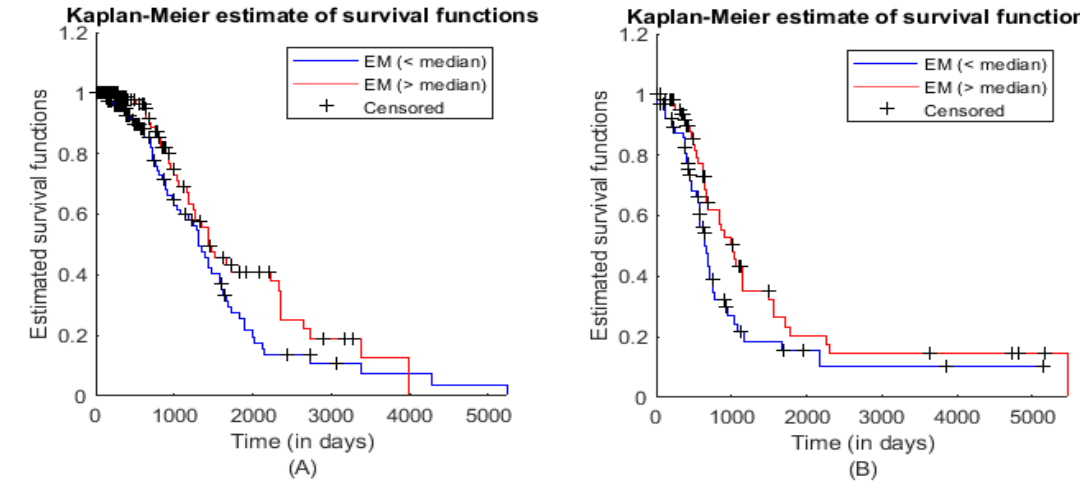
Figure 4. KM plots with log-rank test for module number 5 in ( A ) training and ( B ) test datasets. Table 1. Statistical values of log-rank test for the training dataset corresponding to Figure 4A.